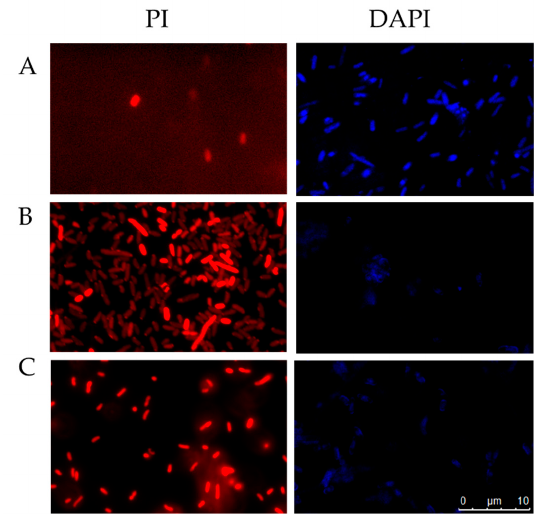
Figure 8. Fluorescence microscopy of E. coli cells incubated for 4 h at 37 °C and stained with PI [56] or DAPI (blue). Untreated control cells, PBS ( A ), cells treated with sarconesin II ( B ), cells treated with ampicillin for PI or ciprofloxacin for DAPI ( C ). PI assay revealed bacterial membrane alteration when treated with sarconesin II and DAPI-stained cells had partial fluorescence, showing DNA fragmentation by sarconesin II.